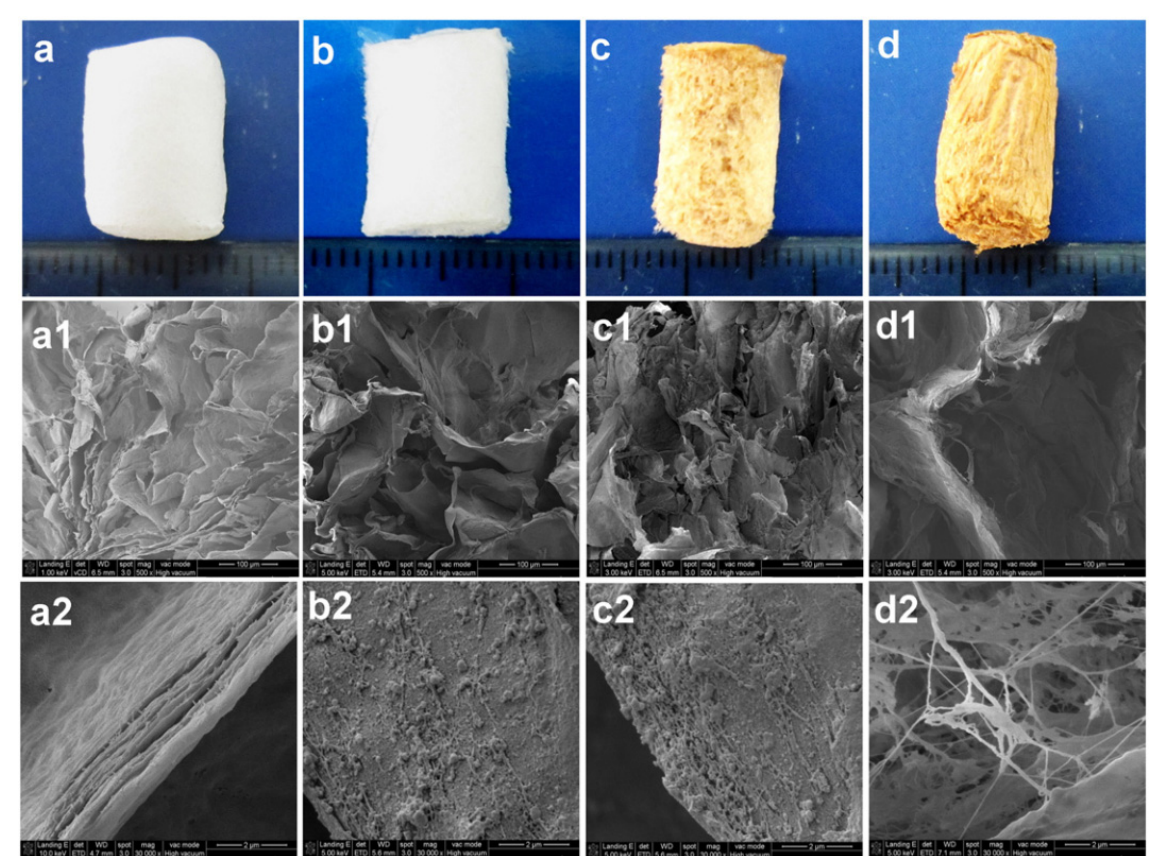
Figure 7. Digital images with outermost characteristics and SEM images of BNC ( a – a2 ), BNC/Gel ( b – b2 ), BNC-PA-Gel ( c – c2 ), and BNC-PA-Gel/HAp ( d – d2 ) cylindrical-shaped scaffolds. Reproduced with permission from [123]. Copyright 2017 Elsevier.